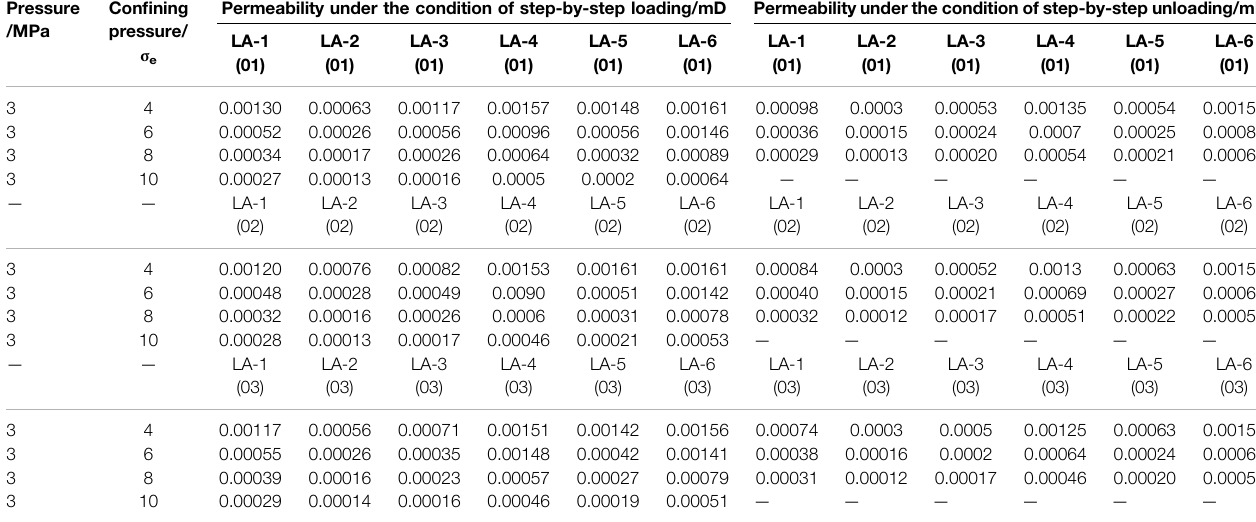
TABLE 2 | Permeability of surrounding rock combination under different effective stresses. Pressure